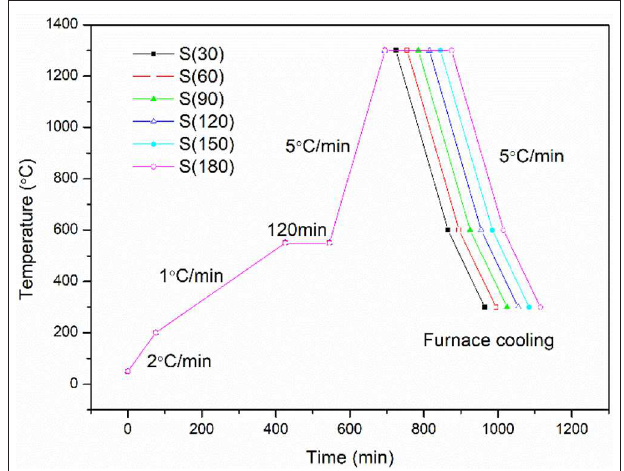
FIGURE 1 | Debinding and sintering processes of the green